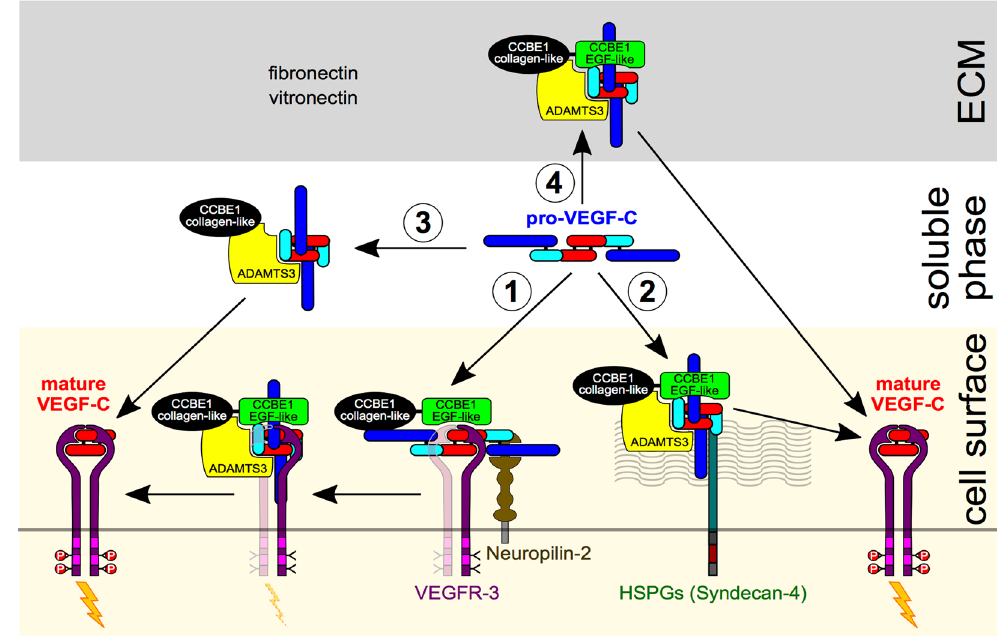
Figure 7. Schematic view of VEGF-C activation based on current experimental evidence. Proteolytic cleavage of pro-VEGF-C simultaneously activates and mobilizes VEGF-C. We propose four different modes of VEGF-C activation: 1. Activation of VEGFR-3-bound VEGF-C 16 ; 2. Activation of HSPG-bound VEGF-C 18 ; 3. Activation of VEGF-C in the soluble phase 11 ; and 4. Activation of ECM-bound VEGF-C. After proteolytic activation, VEGFR-3-bound VEGF-C can immediately start signaling (activation mode #1), while HSPG-bound VEGF-C 18 first needs to translocate to VEGFR-3 (activation mode #2). Although activation of VEGF-C does happen in solution (activation mode #3), the localization of pro-VEGF-C, CCBE1 and ADAMTS3 indicates that a significant fraction of the VEGF-C activation is associated with the ECM (activation mode #4) or cell surfaces (activation modes #1 and #2). In the activation mode #2, pro-VEGF-C is shown to be processed while HSPGs- attached. However, pro-VEGF-C might as well translocate first from HSPGs to VEGFR-3 and become activated while VEGFR-3-bound. The role of CCBE1 is twofold: It accelerates the proteolytic cleavage (mediated by its C-terminal domain) and localizes pro-VEGF-C to efficiently form the trimeric activation complex (mediated by its N-terminal